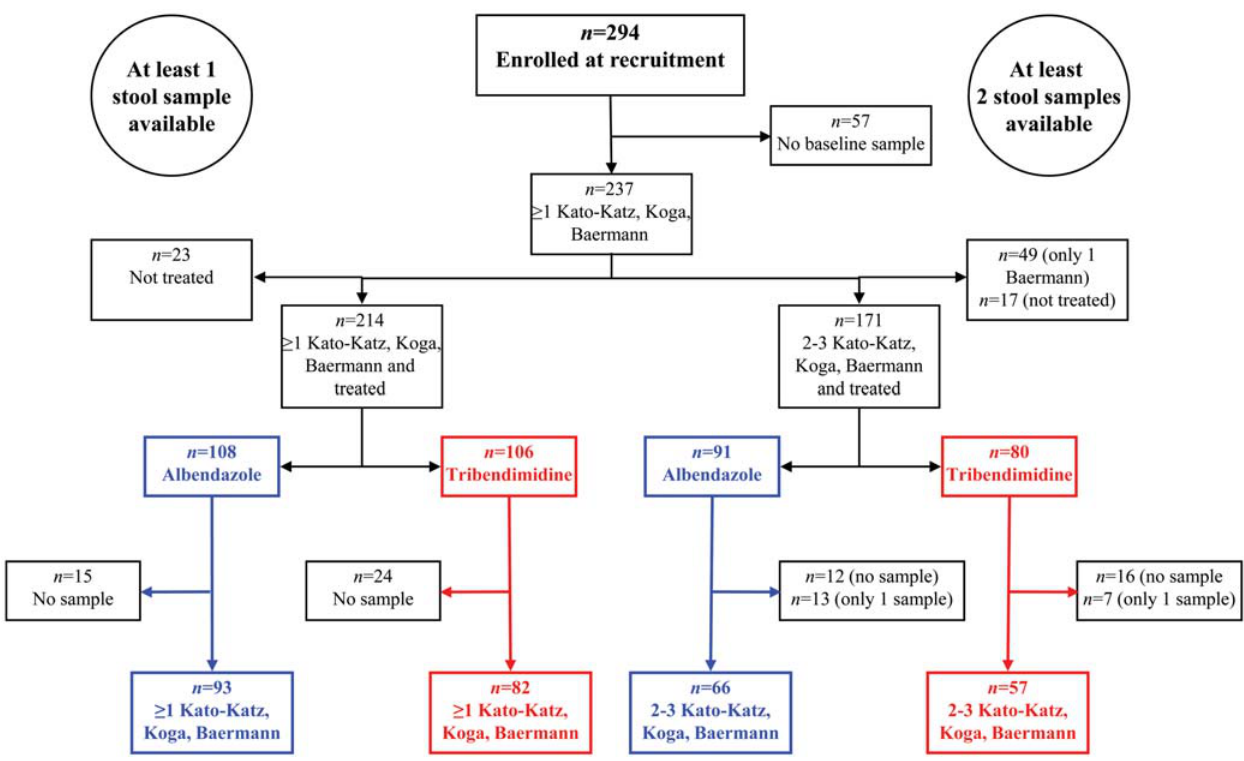
Figure 1. Participation and stool sample submission compliance in a community-based open label efficacy study involving repeated stool sample collection and anthelminthic treatment by either albendazole or tribendimidine; Nanweng village,